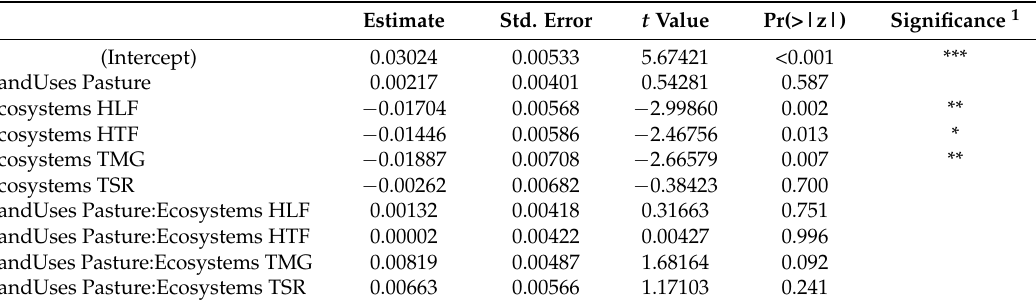
Table 4. Coefficients and level of significance obtained from the generalized linear mixed effect model (GLMM) for SOC as a function of land use, native forest types, and studies, where we considered pasture as the reference level of land use type. Ecosystems: native forests; DTF: dry tropical forests; HLF: highland forest; HTF: humid tropical forests; TMG: tropical mangrove; TSR: tropical scrub and rangelands, LandUses = land uses (Forest versus pasture).